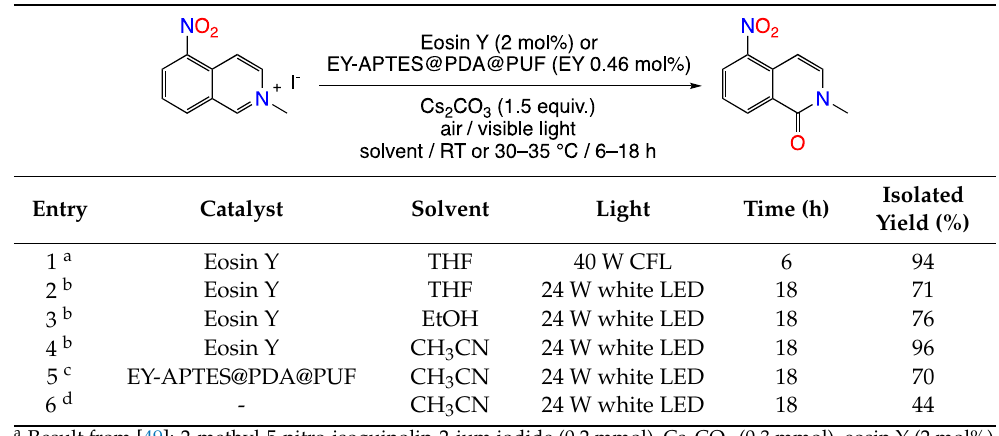
Table 1. Optimization of the reaction conditions for the oxidation of 2-methyl-5-nitro- isoquinolin-2-